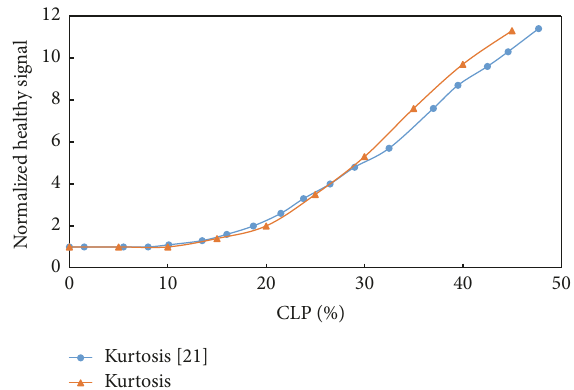
Figure 25: Comparison between the kurtosis values of this study and [21], normalized to the healthy value applied to the residual signal.